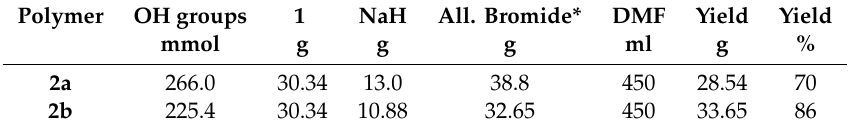
Table 2. Amounts of reagents used for the reaction of alkylation of 1 and the reaction yields. Polymer